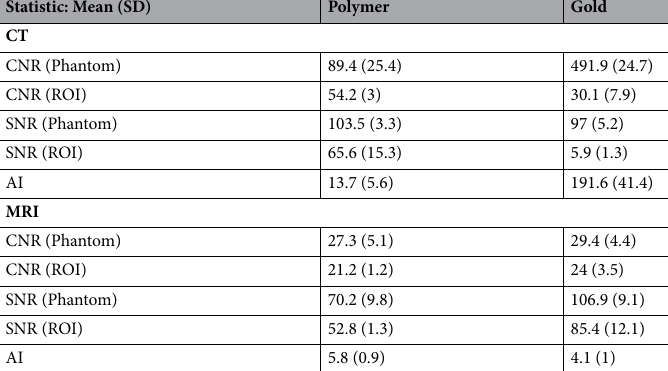
Table 2. Comparison of the Mean (Standard Deviation, SD) of the Contrast to Noise Ratio (CNR), Signal to Noise Ratio (SNR) and Artifact Index (AI) of the polymer and gold fiducials in CT and MRI imaging. The means (SD) relate to the CT number for CT scans and gray-scale for the MRI. Two comparative Backgrounds were used for CNR and SNR, i.e. distant to the artifact for “Phantom”, and the 50 mm square region of interest (ROI) containing the artifact for the “ROI”. CNR = Contrast/Noise = (Fiducial mean − Background mean)/ (Background SD). SNR = Signal/Noise = (Background mean excluding fiducial)/(Background SD excluding 2 Background SD excluding fiducial fiducial). AI = (cid:31) ( ROI SD excluding fiducial ) 2 − . (cid:30) (cid:29)